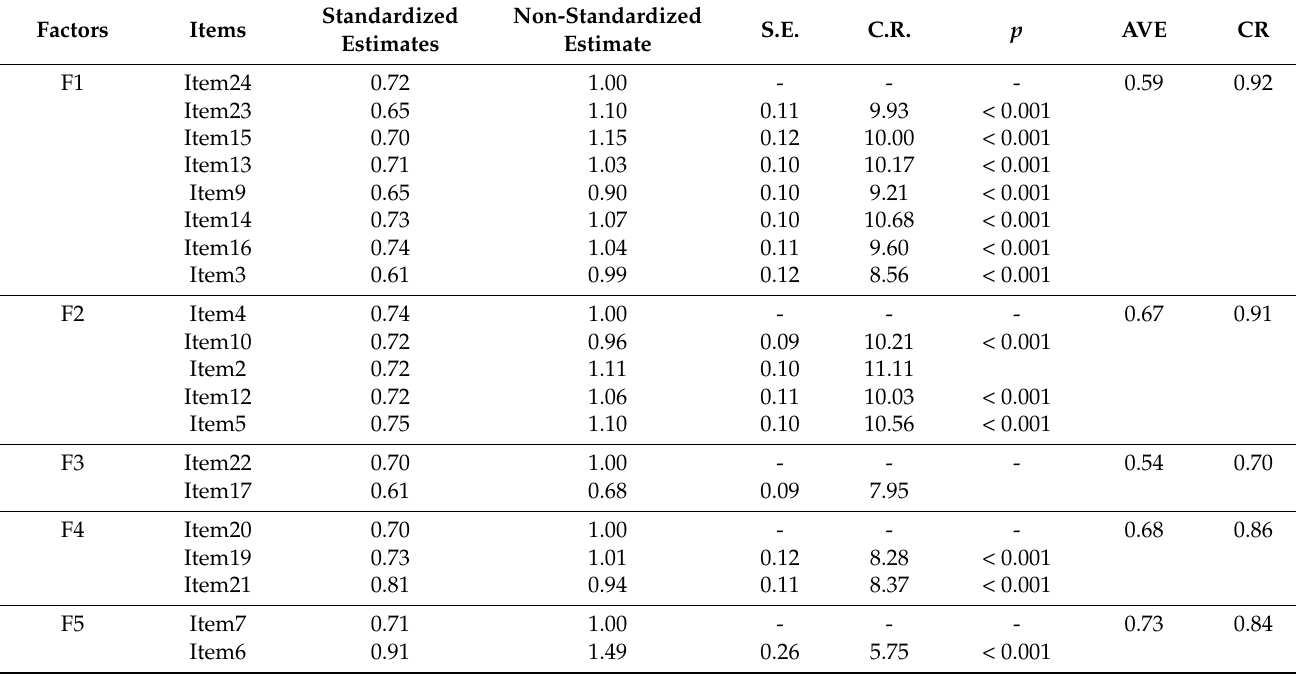
Table 5. Analysis of convergent validity of items ( n = 220).